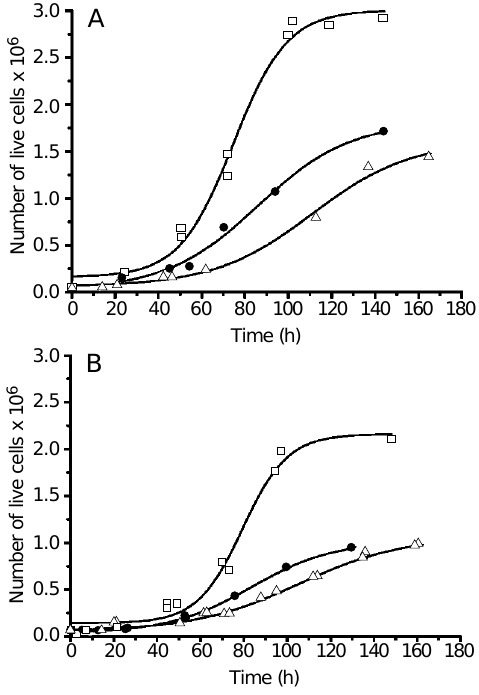
Figure 1. Growth curves for B61 cells (A) and for A31 cells (B) treated with 9 µM of anionic por- phyrin (TPPS 4 ). Control: cells with no photosensitizer and no light (squares). Cells with photo- sensitizer and no light (circles); cells with photosensitizer after light irradiation for 45 min (tri-